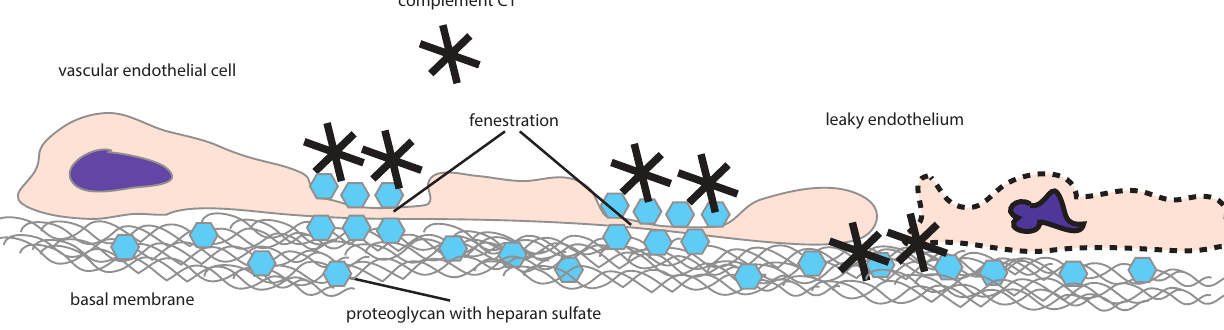
Figure 2. Interactions of C1q with the endothelium. Complement C1q binds to the negatively charged heparan sulfate-rich proteoglycans of the glycocalyx. At leaky endothelial junctions C1q will bind to the subendothelial basal membrane, where it promotes adhesion and